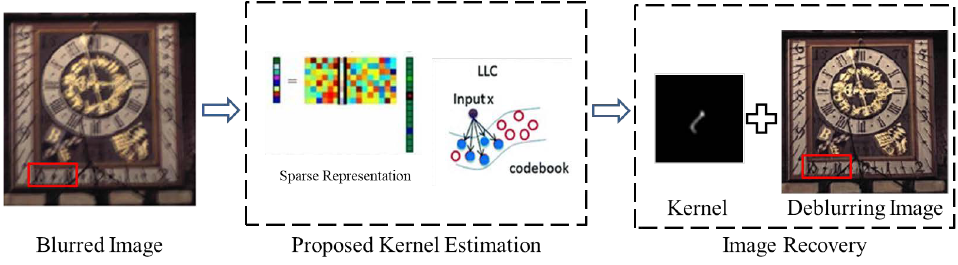
Figure 1. Diagram of the proposed blur kernel estimation